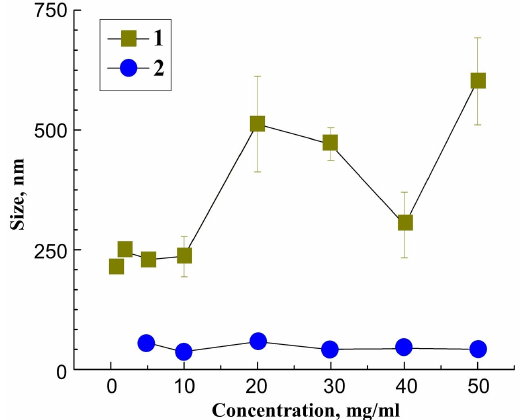
Figure 4. Hydrodynamic size of larger protein (squares) and smaller protein (circles) associates of BSA 5fr molecules, containing physiological amount of fatty acids (native) in the dispersion based on 0.2 M phosphate-buffer solution (pH 5.2) at 25 °C depending on protein concentration.